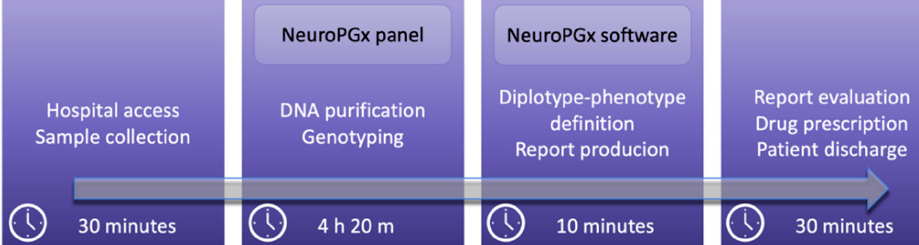
Figure 1. Application model of NeuroPGx system in clinical practice. Excluding the time of admission, clinical visit, and discharge of patients that are highly variable in different clinical centers, the overall time needed by NeuroPGx system is 4 h 30 m.